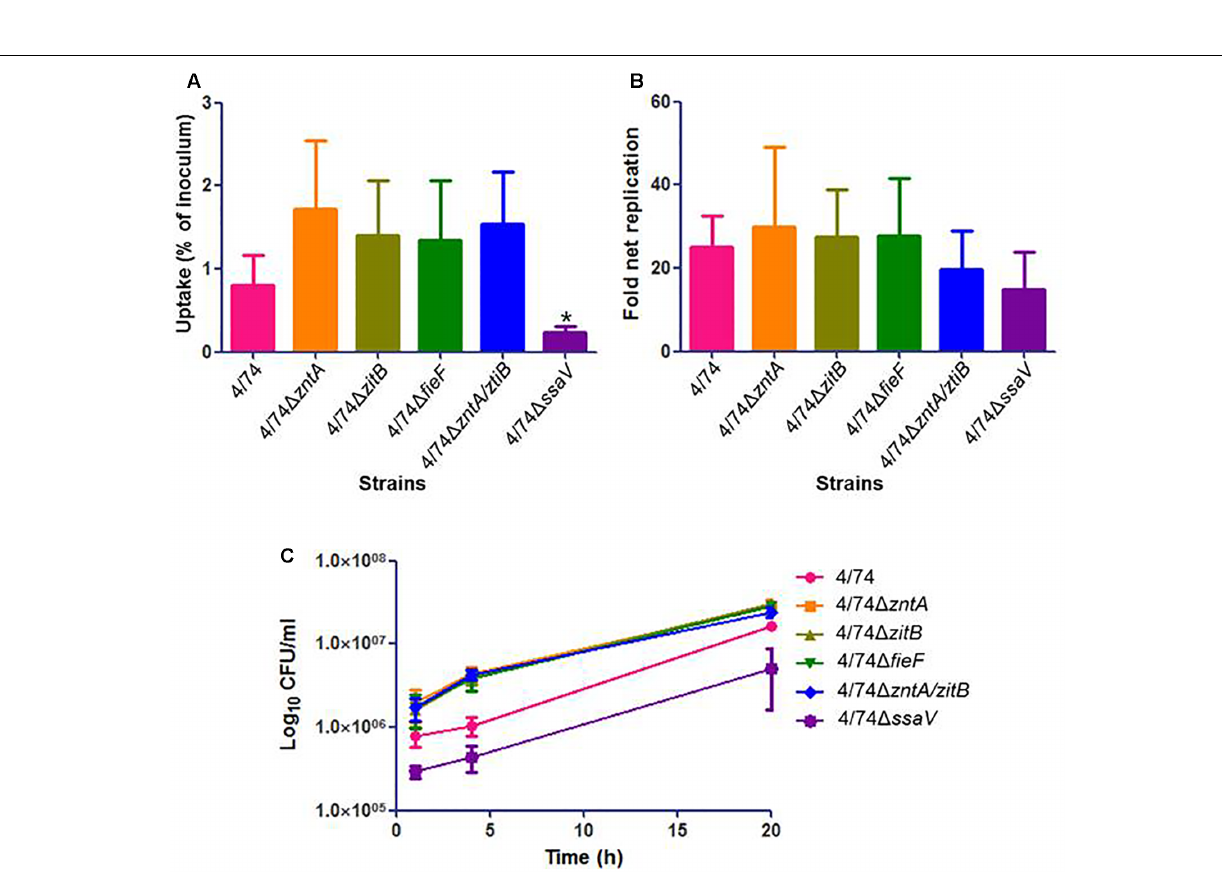
FIGURE 3 | Infection of Nramp1-negative macrophages (J774.1) with the WT and zinc export mutants. (A) Uptake by macrophages (percentage of inoculated bacteria that are able to infect). (B) Fold net replication at t = 20 versus t = 1 h. (C) Survival curves. No significant differences were observed neither in the uptake by macrophages nor in fold net replications between the WT and mutants. At 4 h post-infection, the CFU counts for the mutants 4/74 (cid:49) zntA and 4/74 (cid:49) zntA/zitB were significantly higher than those detected for the WT ( P -value < 0.05) although the fold net replications at this time point compared to t = 1 h were not significantly different between WT and mutants (not